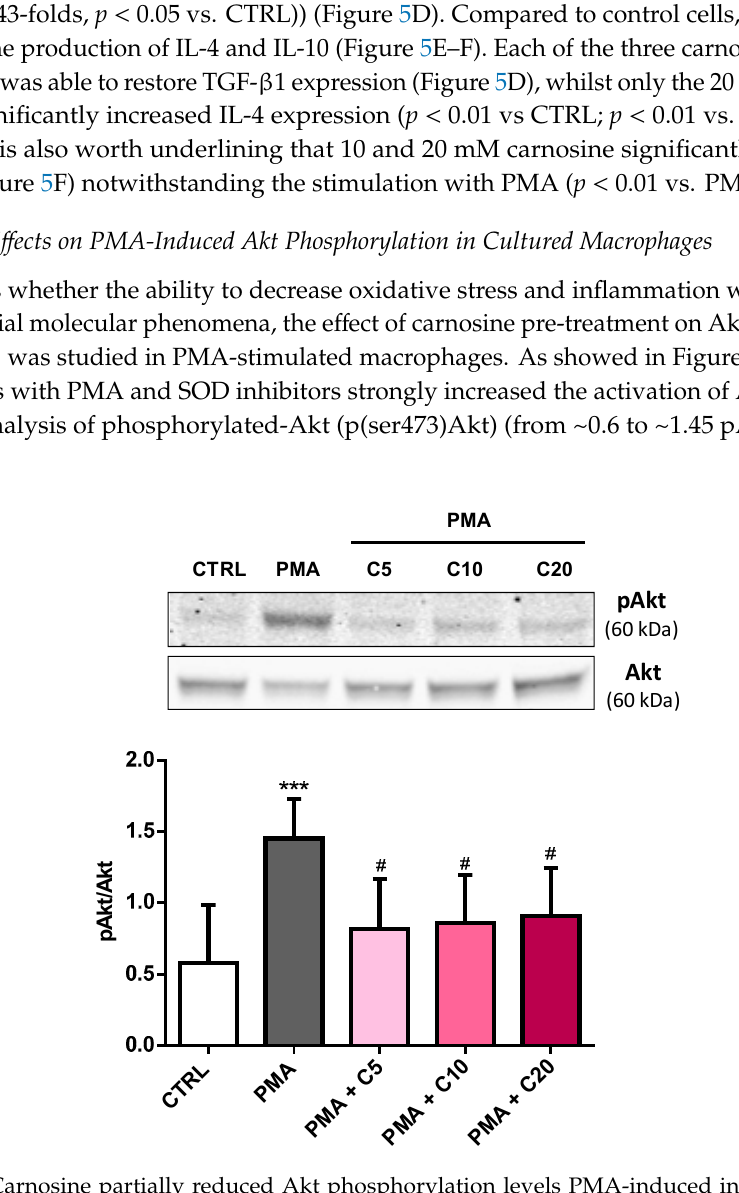
Figure 6. Carnosine partially reduced Akt phosphorylation levels PMA-induced in macrophages. Representative immunoblots of phosphorylated Akt (p(ser473)Akt) and total Akt (Akt) in total protein extracts from resting (control) macrophages and macrophages stimulated with PMA and SOD inhibitors, in absence or presence of increasing concentrations (5, 10, or 20) of carnosine. Histograms refer to the means ± SD of five independent experiments. The densitometric values of pAkt bands were normalized against Akt. *** p < 0.001 vs. CTRL; # p < 0.05 vs. PMA. Carnosine was able to significantly attenuate this phenomenon (from ~1.45 to ~0.85 pAkt/Akt, p < 0.05) but no differences were observed between the three concentrations tested.